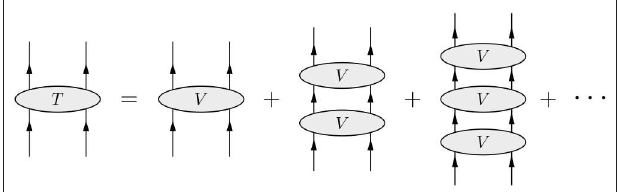
FIGURE 2 | Graphical representation of the Lippmann-Schwinger equation.